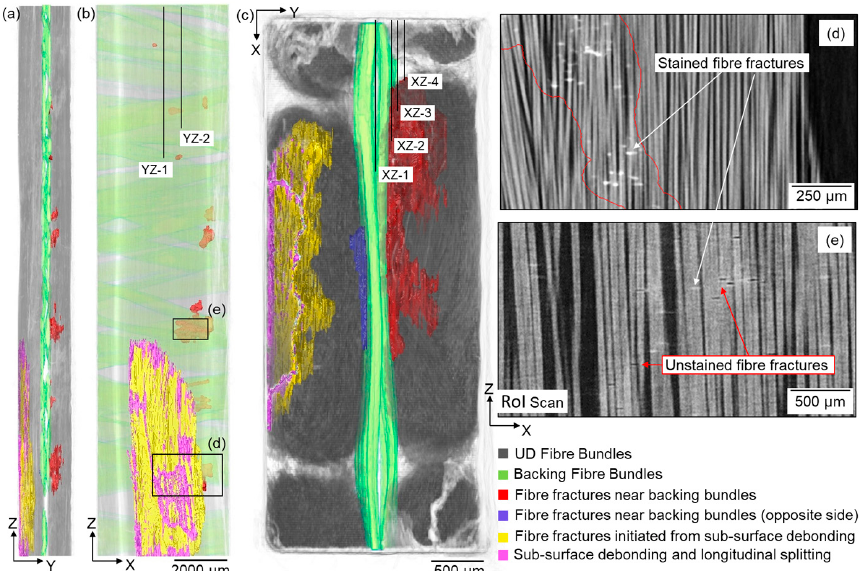
Figure 3. X-ray CT 3D volume rendering of the extracted damage after 500,000 cycles (N 2 ), where the fibre fractures, longitudinal splits and debonding are visualised with respect to the UD and backing fibre bundles, ( a ) YZ view, ( b ) XZ view, ( c ) XY view (refer to Figure 2a,b for definition of the coordinate system). ( d ) Typical virtual X-ray CT XZ of the region marked in ( b ), illustrating the manual annotation of fibre fracture damage in the CT image. ( e ) High-resolution RoI X-ray CT virtual XZ section of the damage region marked in ( b ) where some fibre fractures were not stained.